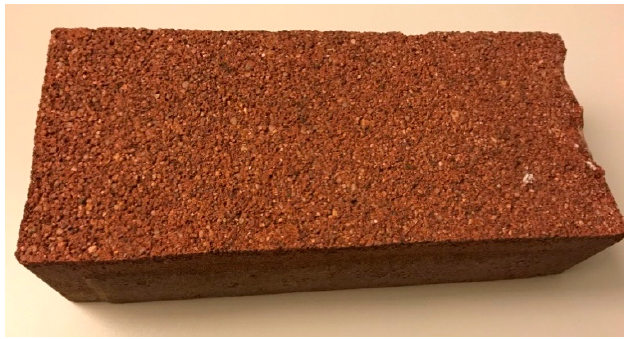
Figure 2. Photocatalytic concrete pavement block.